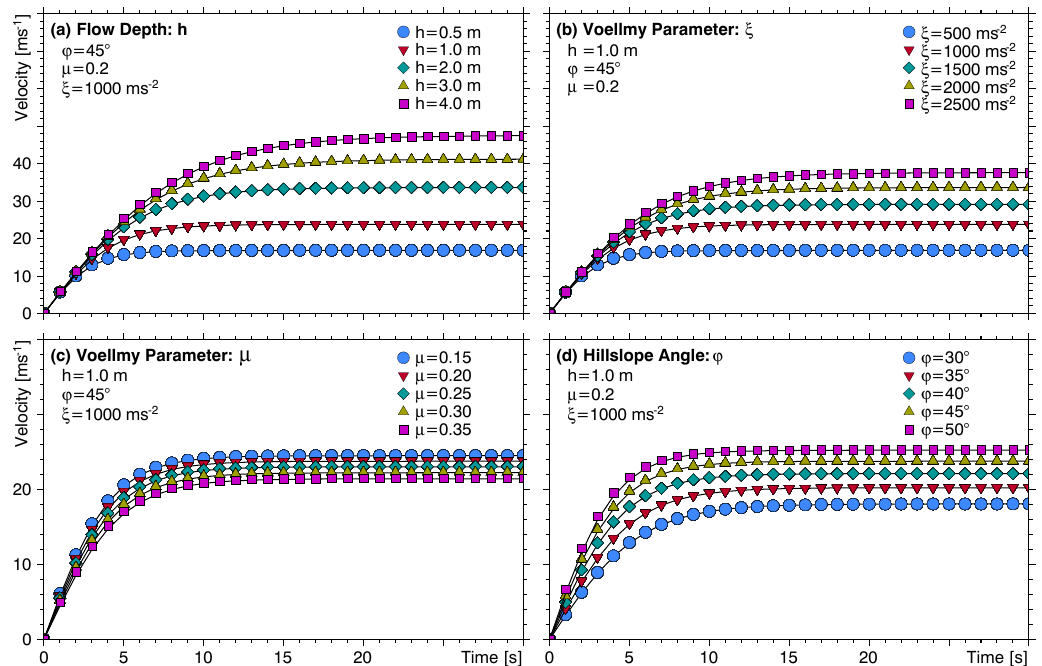
Figure 3. Test of the numerical results of GERRIS Zb (symbols) against the one-dimensional analytical time-dependent solution for a Voellmy fluid flowing on a flow path with a constant slope (Eq. 30, solid lines) for several parameter sets for (a) flow depth h , (b) turbulence parameter ξ , (c) dry friction parameter µ , and (d) slope angle ϕ